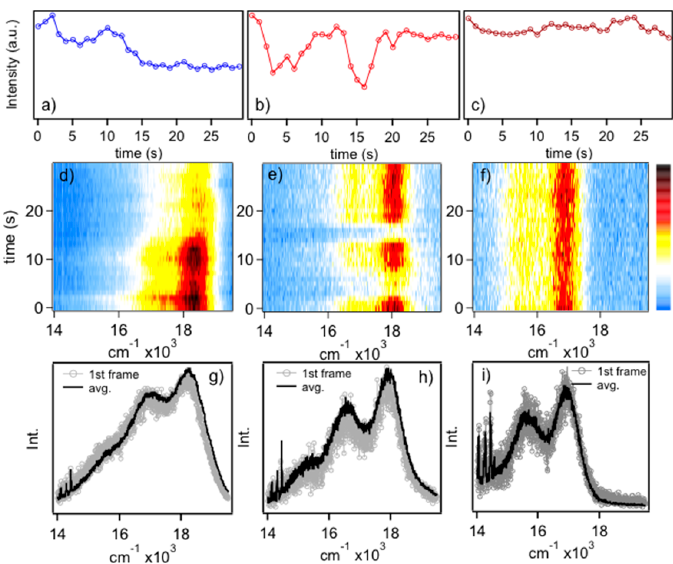
Figure 1. Examples of: PL (photoluminescence) integrated intensity transients ( a – c ); PL spectra transients ( d – f ); and PL spectra ( g – i ) of the first frame (gray) and average (black) of the “blue”, “red” and “ultra-red” emitting forms of MEH-PPV (poly[2-methoxy-5-(2-ethylhexyloxy)-1,4-phenylenevinylene]) single molecules. Spike features appearing on the lower energy tail of the PL line shape correspond to plasma lines from the laser excitation source.